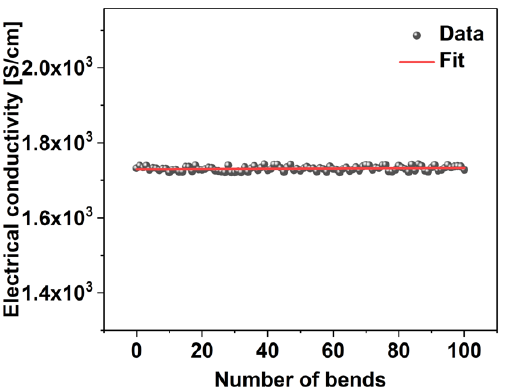
repeated bending of the composite on its electrical conductivity (Figure 6).